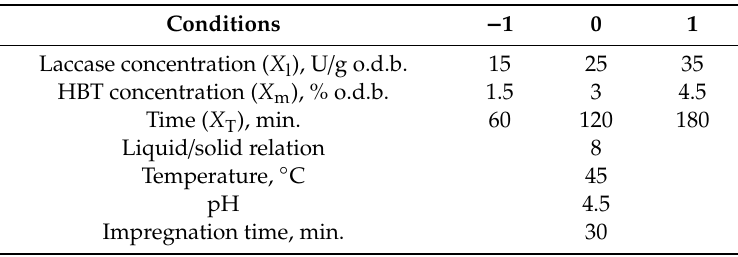
Table 1. Operating conditions and variables of experimental design enzymatic-mediator treatment. Conditions − 1 0 1 Laccase concentration ( X l ), U / g o.d.b. 15 25 35 HBT concentration ( X m ), % o.d.b. 1.5 4.5 Time ( X T ), min. 60 180 Liquid / solid relation Temperature, ◦ C 4.5 Impregnation time, min.